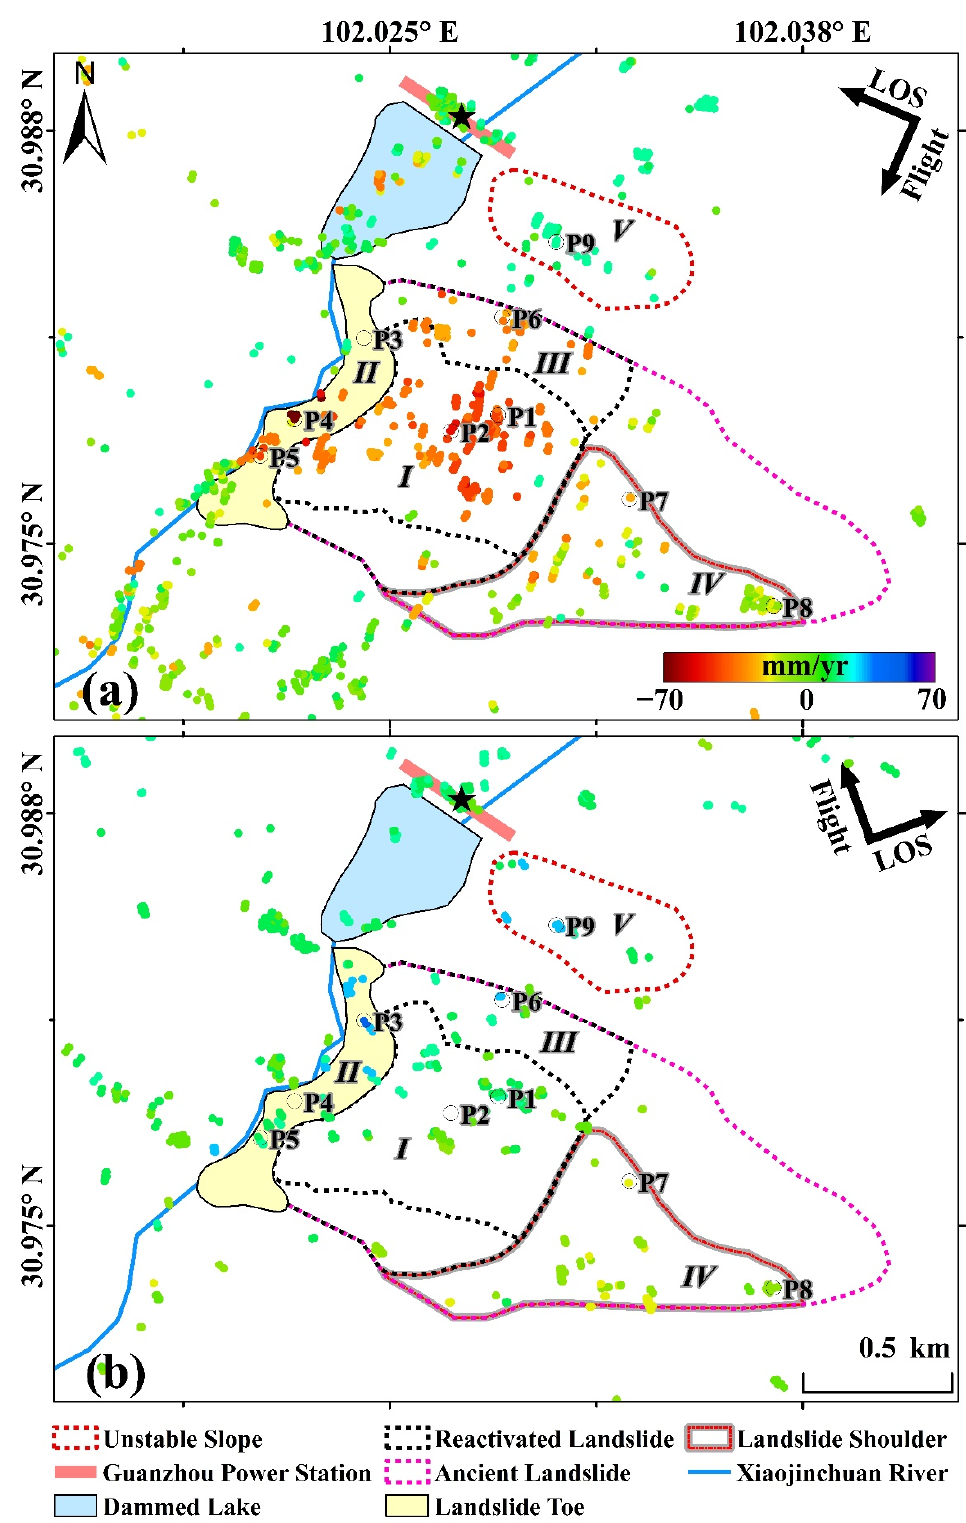
Figure 8. LoS deformation velocity detected from the Sentinel-1: ( a ) descending dataset and ( b ) ascending datasets. Black star represents the reference point, and the black circles represent the selected measurement points.